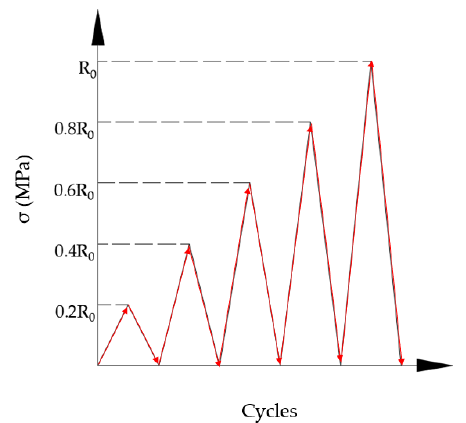
Figure 3. Rock sample for uniaxial graded cyclic loading and unloading test.